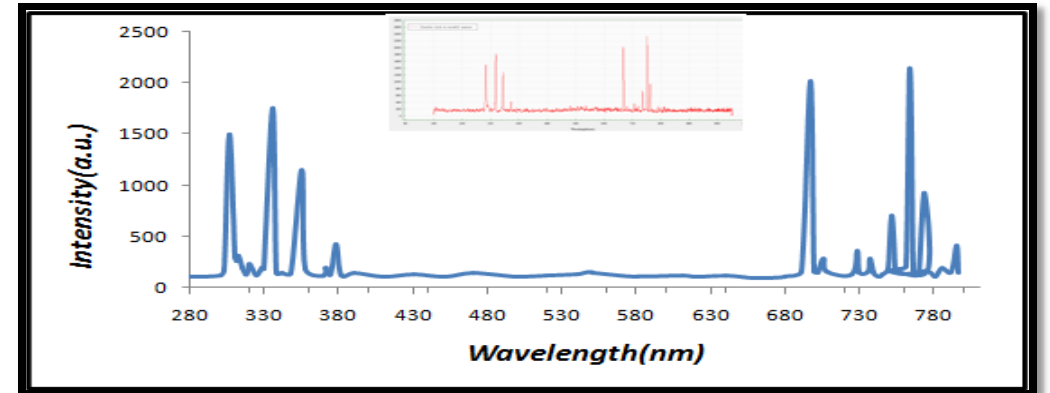
Fig. 6: Spectra of Ar plasma operated in open